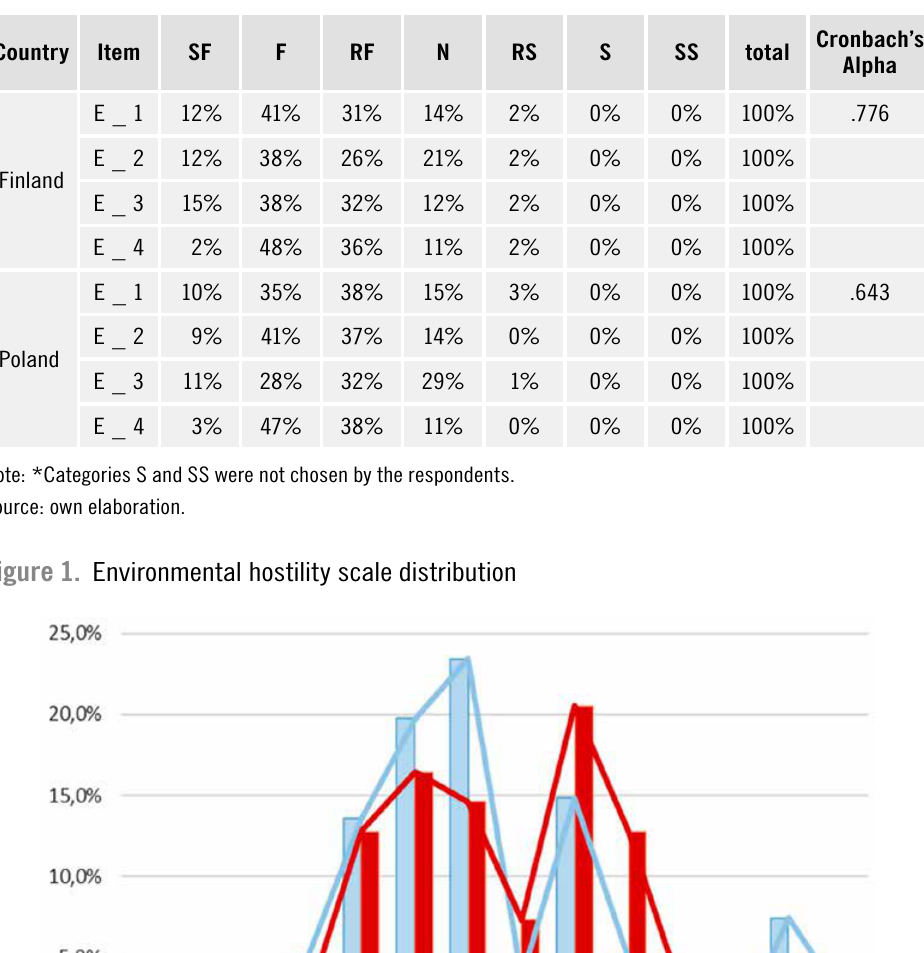
Table 2. Distribution of answers to the environmental hostility scale’s statement by the studied SME in Finland and Poland and Cronbach’s alpha